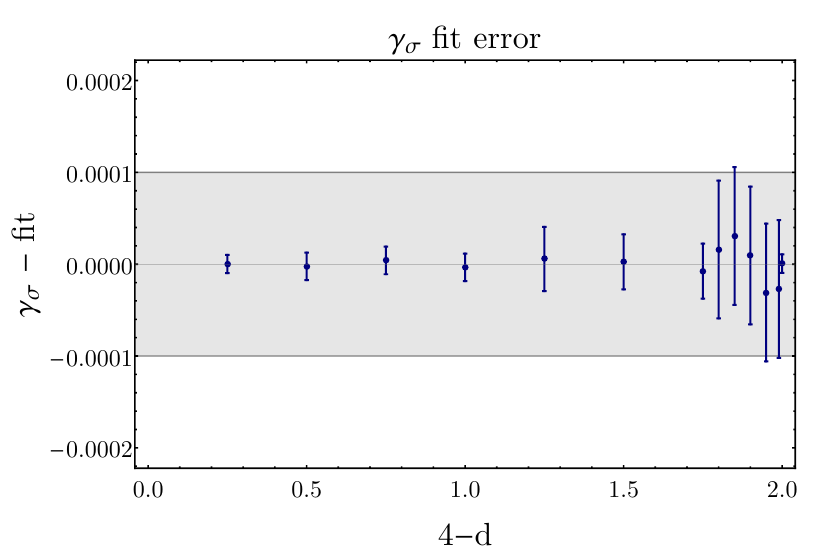
Figure 4 . Quality of the polynomial (cid:12)t for (cid:13) (cid:27) (4 (cid:0) d ) bootstrap data in the range of dimensions 4 > d (cid:21) 2. The maximal overall error of the (cid:12)t is indicated by a grey band.